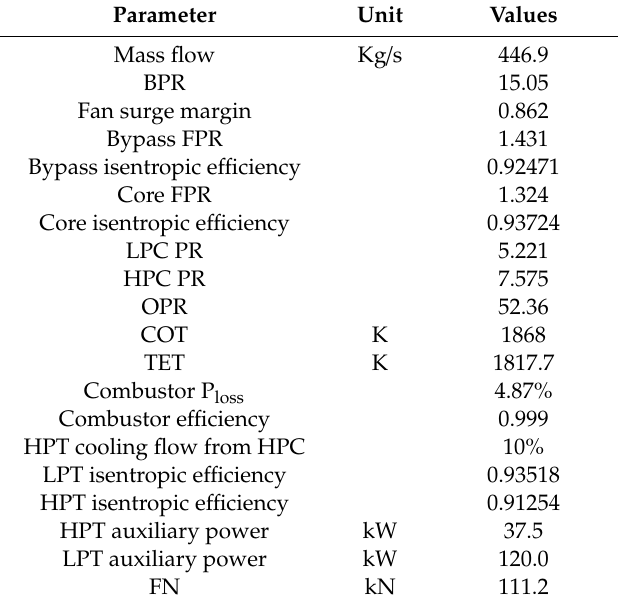
Table 2. DP (T / O) optimized parameters (International Standard Atmosphere (ISA)) for the UHBR-GTF.